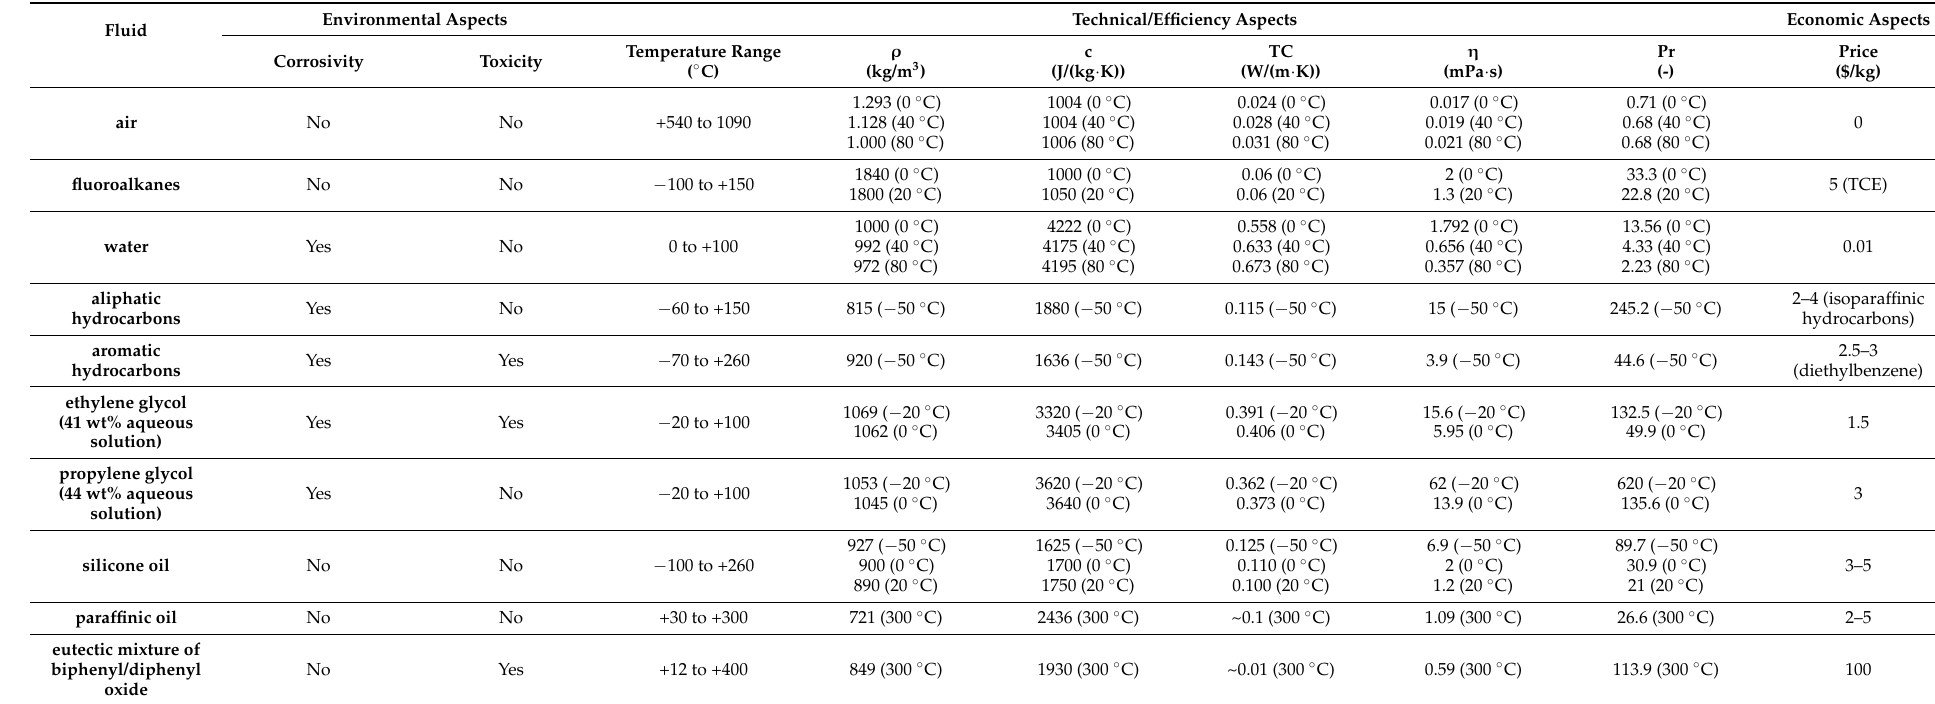
Table 1. Environmental, technical, and economic aspects comparison of examples of conventional heat transfer